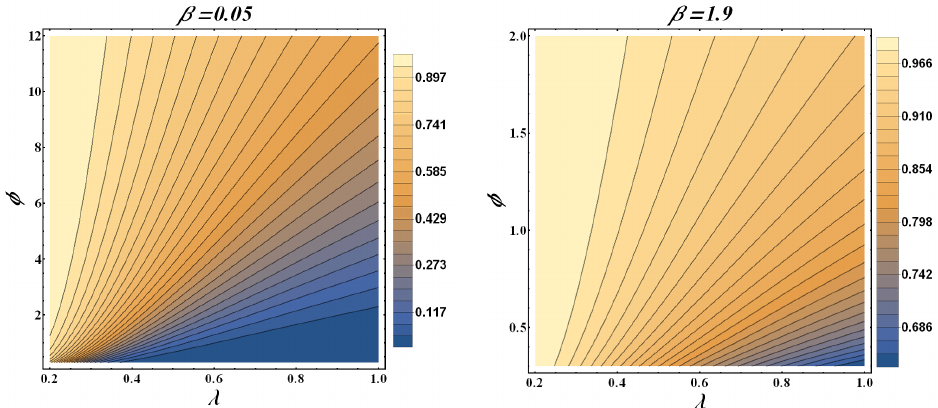
(cid:0) ˘ Θ (cid:1) Fig. 7. Plot of median of HLUG-TI for certain parameter values. Figure 7. Plot of median of HLUG-TI for certain parameter